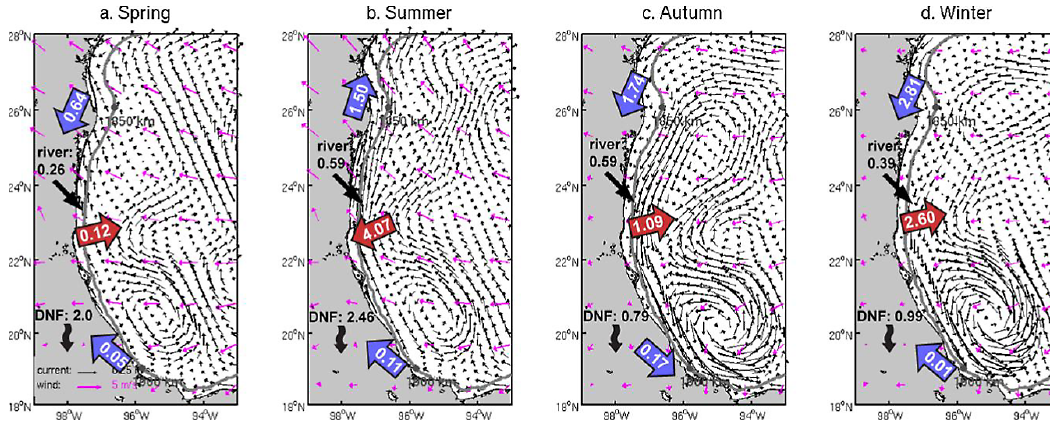
Fig. 14. Similar to Fig. 13 but for the TAVE